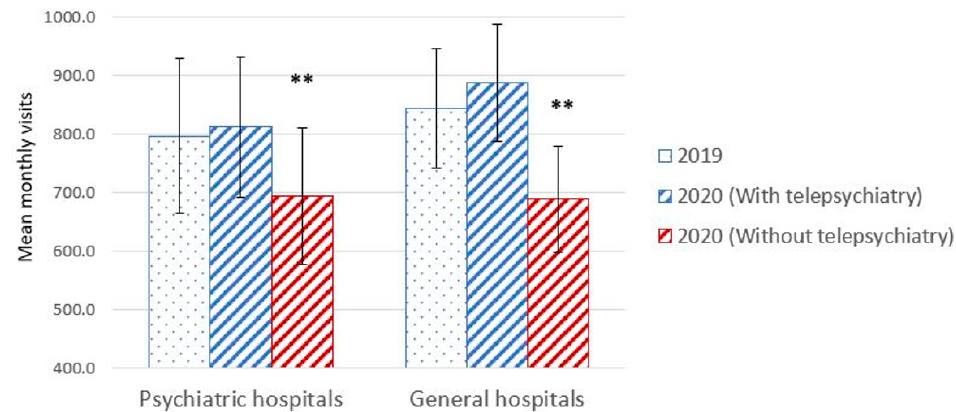
Figure 4. Monthly visits to psychiatric hospitals and general hospitals in 2019 as compared to 2020. Bars relate to standard deviation. ** p < 0.01.